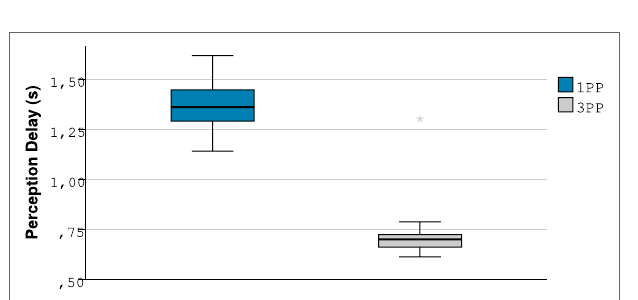
FigUre 13 | Boxplot of the total duration of the navigation phases with and without